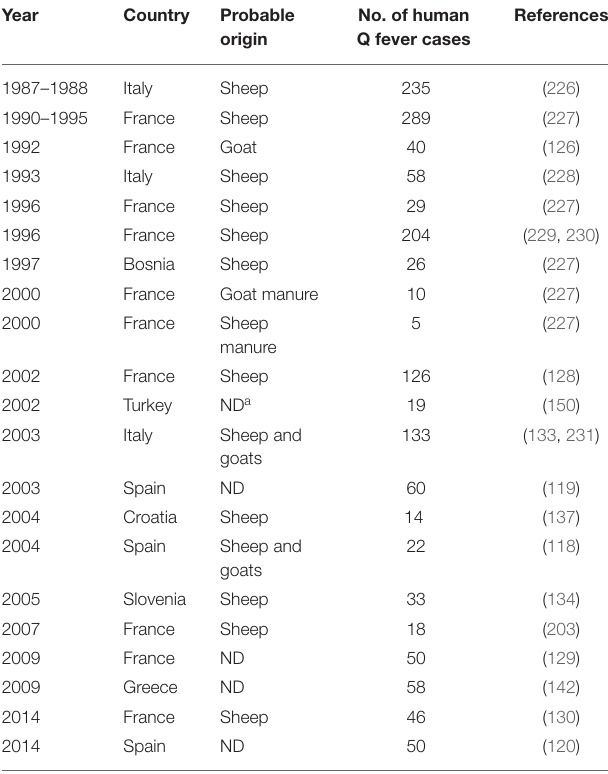
TABLE 1 | History of the main human Q fever epidemics in countries of the Northern coast of the Mediterranean Sea and identification of the zoonotic source of C. burnetii